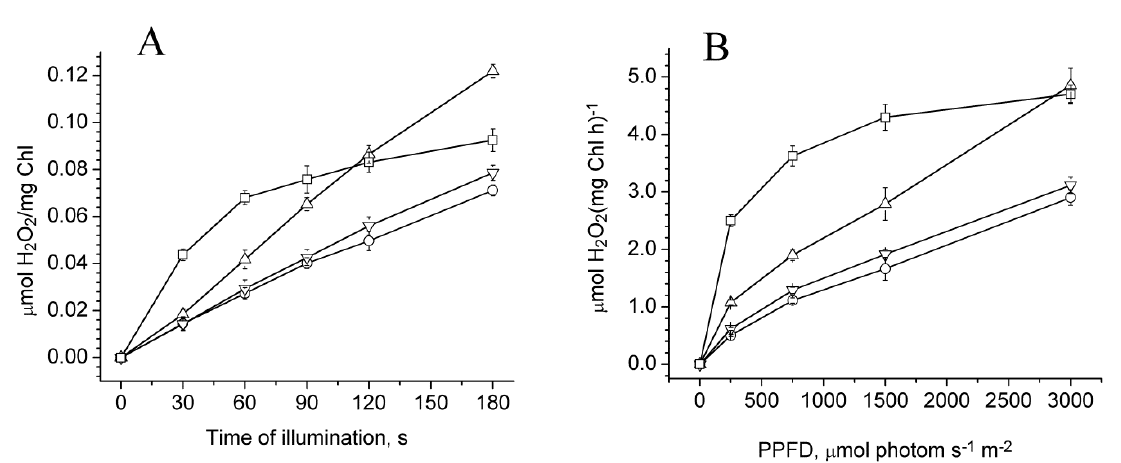
Figure 2. H 2 O 2 photoproduction in PSII membranes before ( ) and after NaCl ( (cid:53) ), CaCl 2 ( (cid:52) ), and NH 2 OH ( (cid:3) ) treatments. ( A ) Dependence of H 2 O 2 photoproduction in the PSII membranes on the duration of illumination ( λ > 600 Hm, 1500 µ mol photon s − 1 m − 2 ). ( B ) Dependence of H 2 O 2 photoproduction in the PSII membranes on light intensity (the samples were illuminated at various light intensities for 1 min). The illumination of the samples was done in a medium containing 20 mM MES–NaOH (pH 6.5), 35 mM NaCl, and 0.4 M sucrose at 25 ◦ C. The concentration of chlorophyll during illumination was 50 µg/ml.